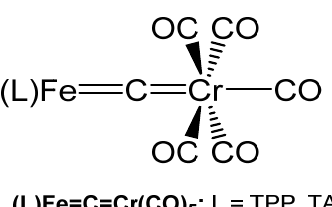
Figure 41. Structural representation of the Fe = C = Cr carbido complexes (TPP)Fe = C = Cr(CO) 5 and (TAP)Fe = C = Cr(CO) 5 .